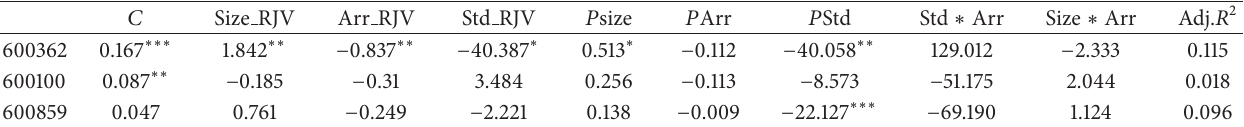
Table 10: Forecasting one-month-ahead individual returns using realized jump volatility-based factor model with cross-term.